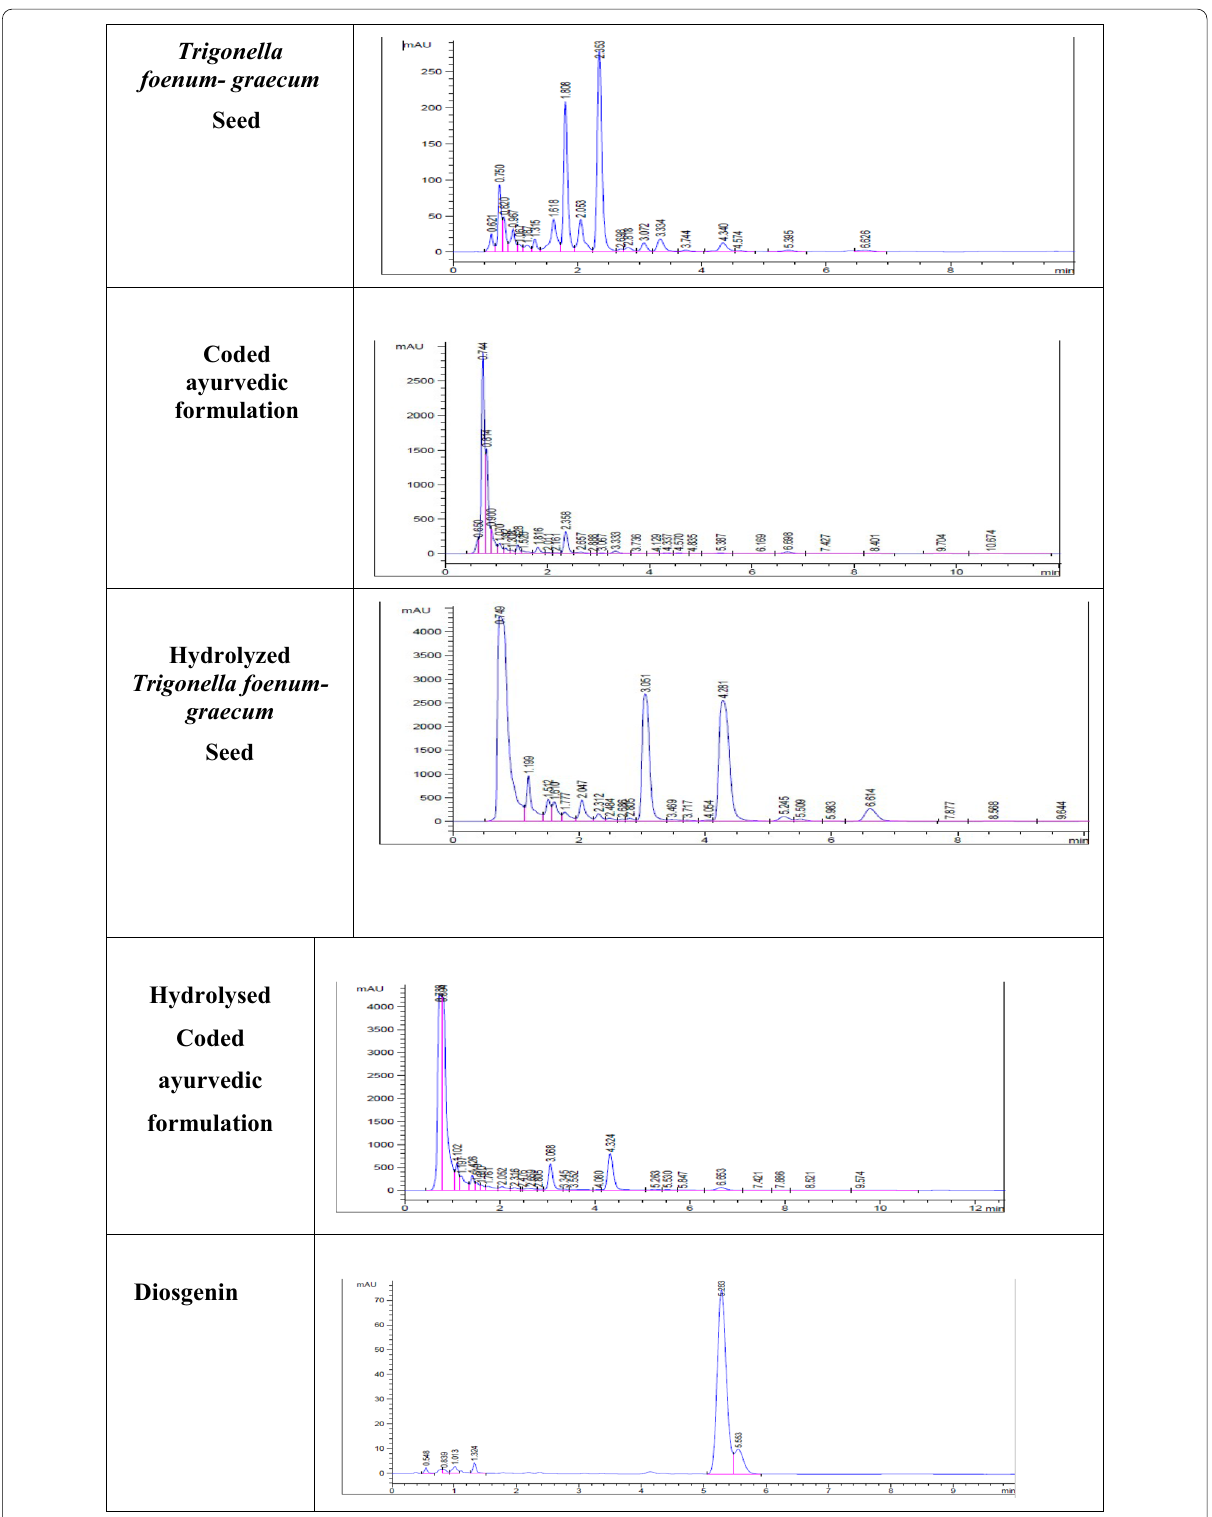
Fig. 8 HPLC chromatogram of Diosgenin biomarker compound in coded formulation tablet and Trigonella foenum-graecum